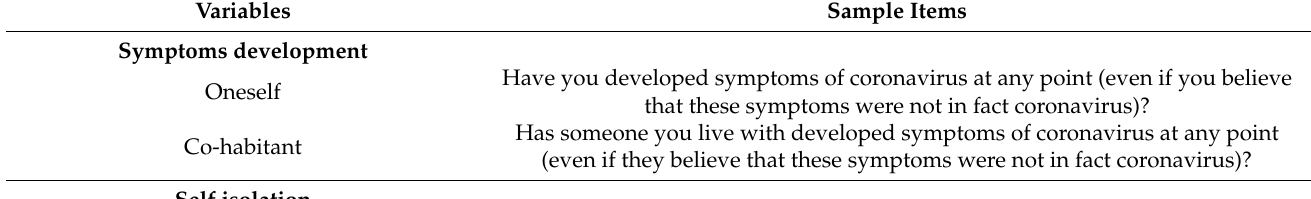
Table 1. Sample items of research